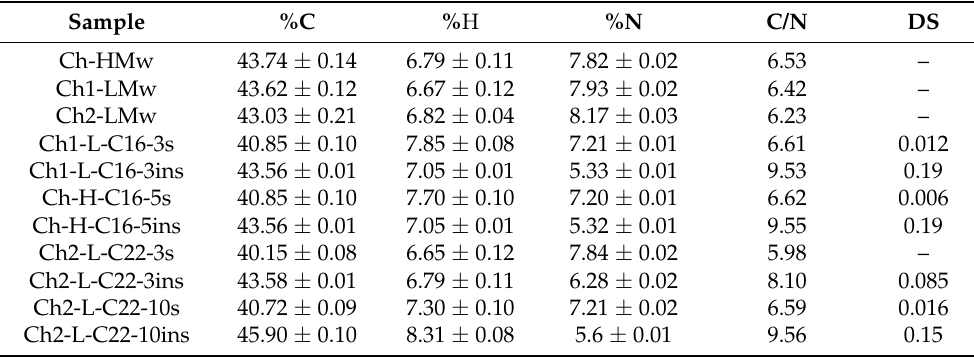
Table 3. Elemental analysis data for the initial chitosan samples and the products of their interaction with alkylation